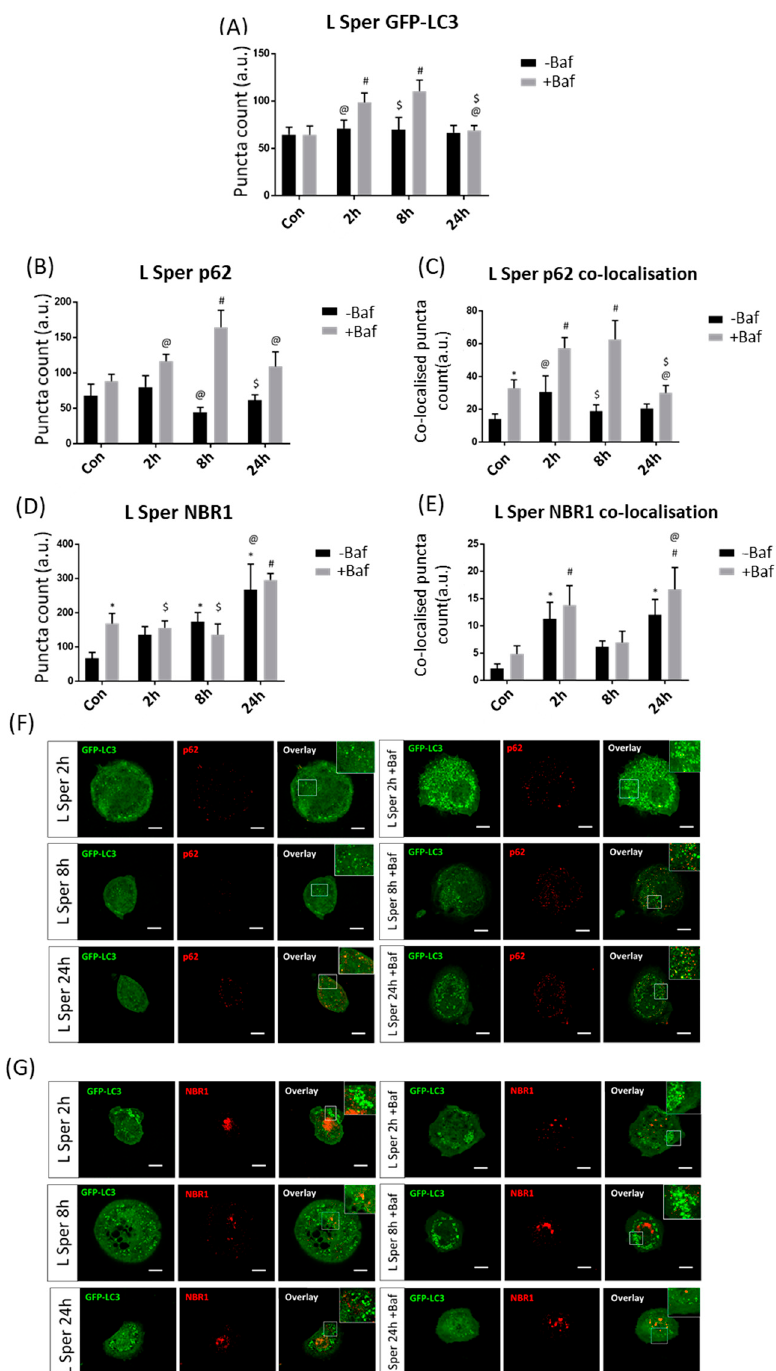
Figure 6. Puncta count analysis following 5 µ M spermidine (L Sper) over 24 h in the presence (+Baf) and absence ( − Baf) of bafilomycin. ( A ) Total GFP-LC3 puncta analysis. N = 24. # p < 0.05 vs. Con +Baf, @ p < 0.05 vs. 2 h +Baf, $ p < 0.05 vs. 8 h +Baf. ( B ) Total p62 puncta analysis. N = 12. # p < 0.05 vs. Con +Baf, @ p < 0.05 vs. 8 h +Baf, $ p < 0.05 vs. 24 h +Baf. ( C ) Co-localised GFP-LC3/p62 puncta analysis. N = 12. * p < 0.05 vs. Con, # p < 0.05 vs. Con +Baf, @ p < 0.05 vs. 2 h +Baf, $ p < 0.05 vs. 8 h +Baf. ( D ) Total NBR1 puncta analysis. N = 12. * p < 0.05 vs. Con, # p < 0.05 vs. Con +Baf, @ p < 0.05 vs. 2 h − Baf, $ p < 0.05 vs. 24 h +Baf. ( E ) Co-localised GFP-LC3/NBR1 puncta analysis. N = 12. * p < 0.05 vs. Con, # p < 0.05 vs. Con +Baf, @ p < 0.05 vs. 8 h +Baf. ( F ) Representative fluorescence micrographs showing GFP-LC3 and p62 puncta. ( G ) Representa-tive fluorescence micrographs showing GFP-LC3 and NBR1 puncta. Scale bar = 10 µ